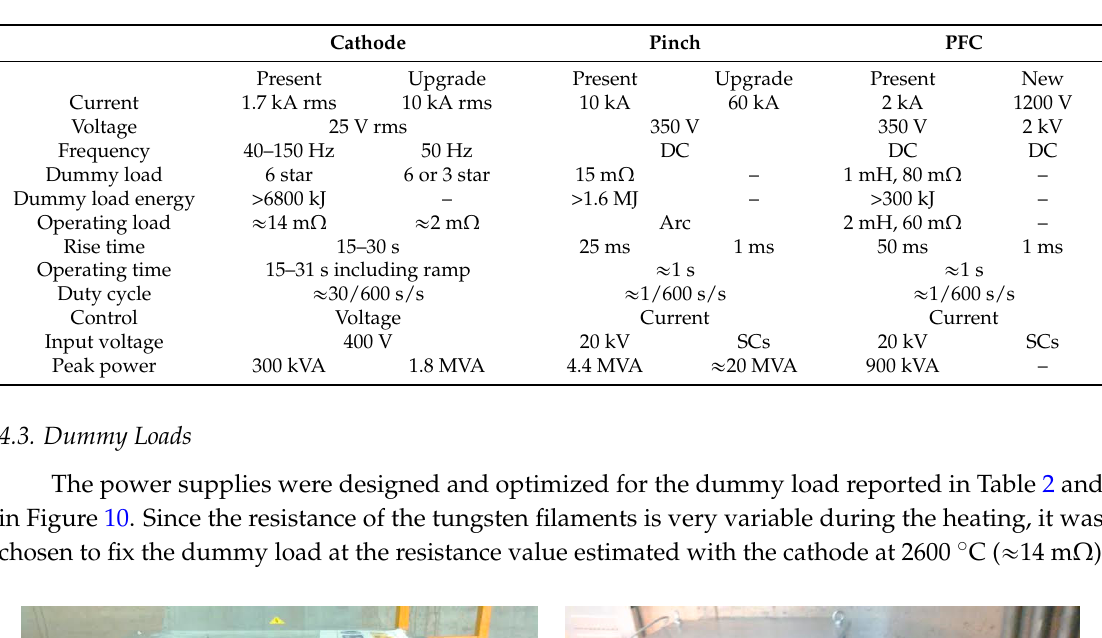
Table 2. Summary of PROTO-SPHERA power supplies. The upgraded characteristics will be refined taking into account the first experimental results.